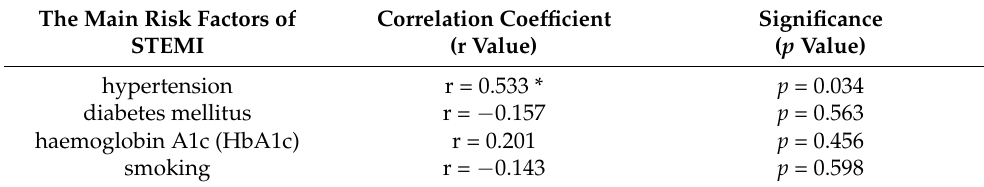
Table 4. Correlation between the main risk factors of STEMI and the plasma PACAP levels.